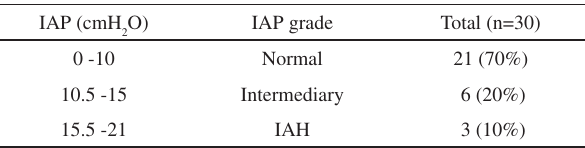
Table 2 - Intra-abdominal pressure grade at the beginning of the